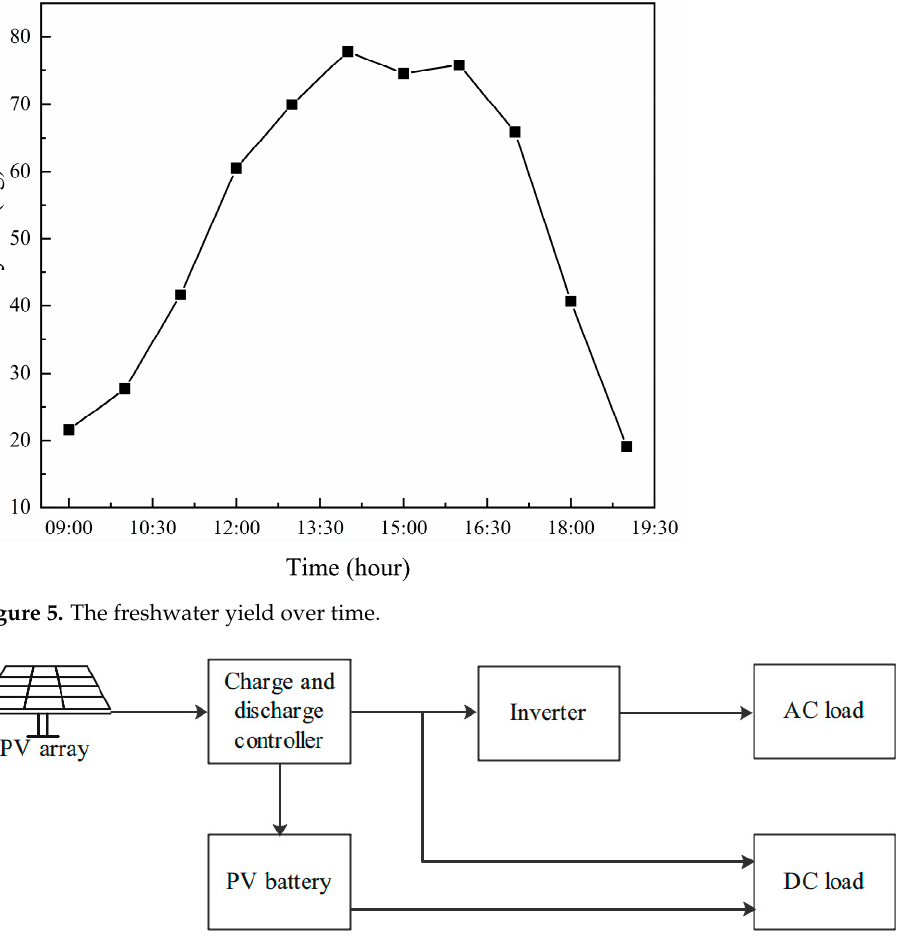
Figure 5. The freshwater yield over time.